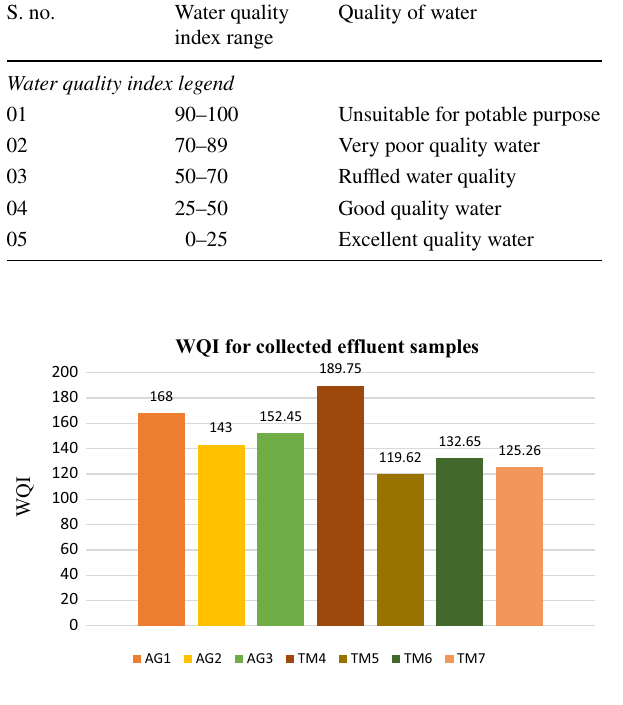
Table 7 Water quality index report status S. no.